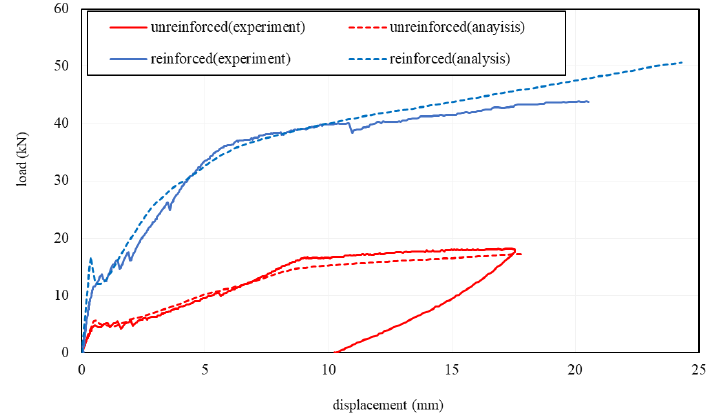
Figure 9. Comparison of the load-displacement relationship.